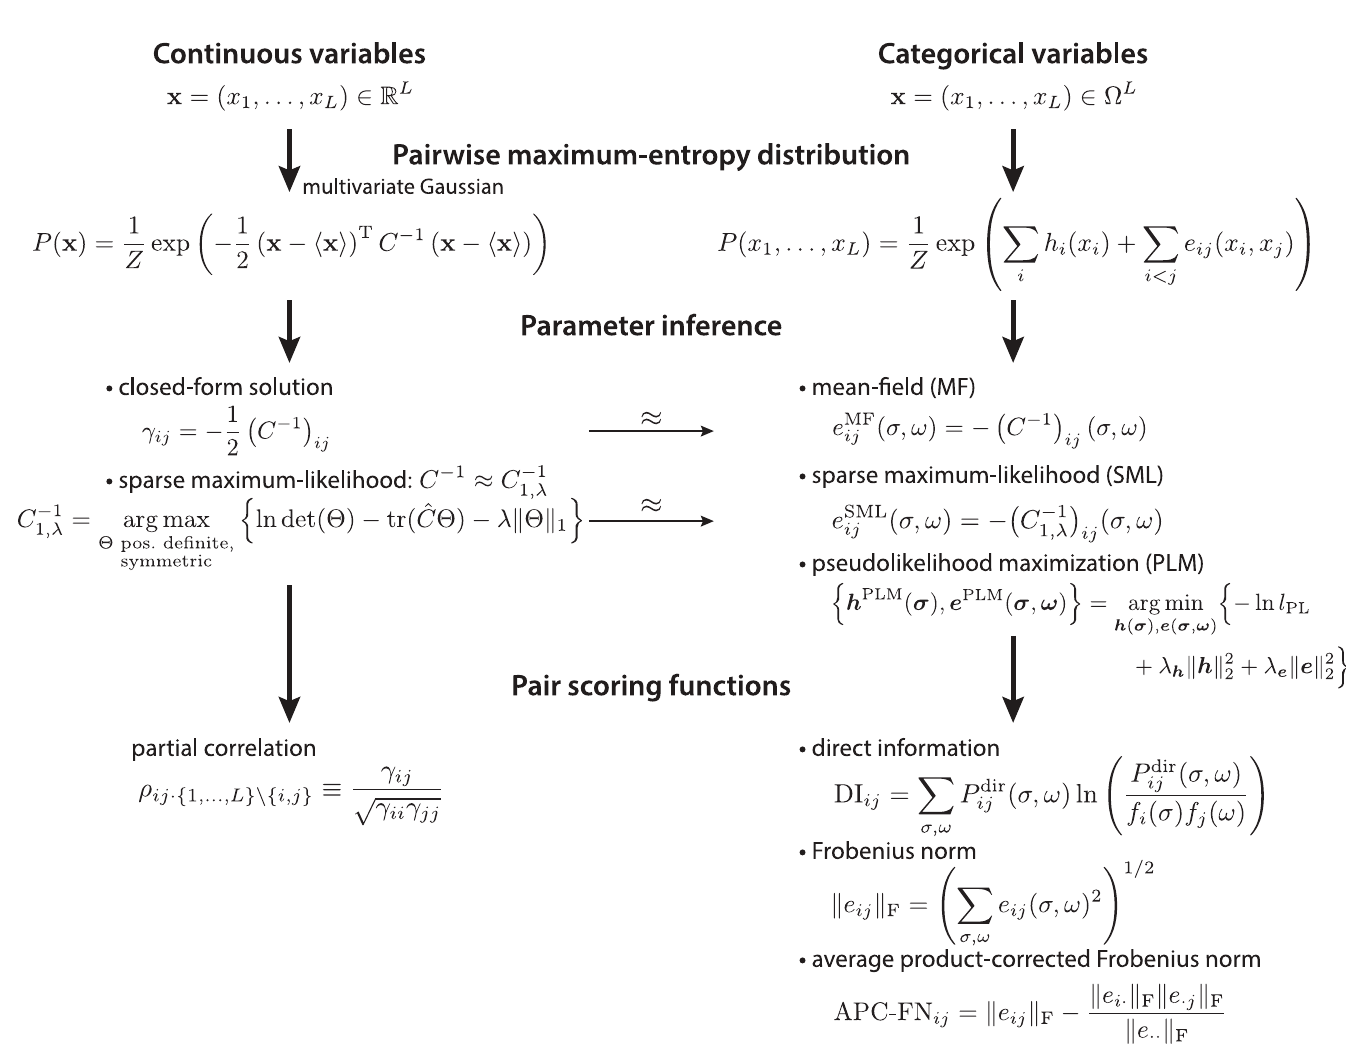
Fig 3. Scheme of pairwise maximum-entropy probability models. The maximum-entropy probability distribution with pairwise constraints for continuous random variables is the multivariate Gaussian distribution (left column). For the maximum-entropy probability distribution in the categorical variable case (right column), various approximative solutions exist, e.g., the mean-field, the sparse maximum-likelihood, and the pseudolikelihood maximization solution. The mean-field and the sparse maximum-likelihood result can be derived from the Gaussian approximation of binarized categorical variables (thin arrow). Pair scoring functions for the continuous case are the partial correlations (left column). For the categorical variable case, the direct information, the Frobenius norm, and the average product-corrected Frobenius norm are used to score pair couplings from the inferred parameters (right column).